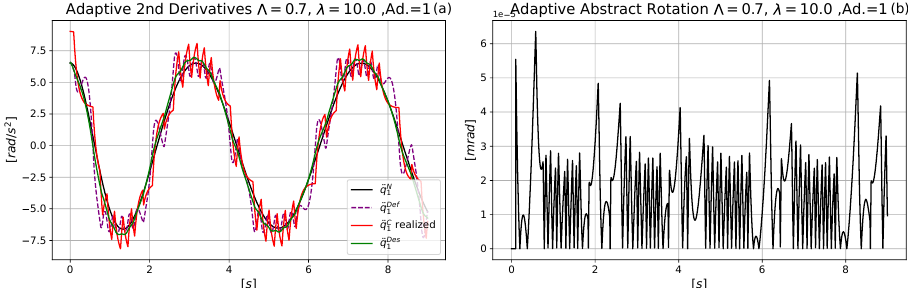
Figure 8. The operation of the adaptive controller. ( a ): The desired, deformed, and realized 2nd time-derivatives. ( b ): The angle of the adaptive abstract rotation.